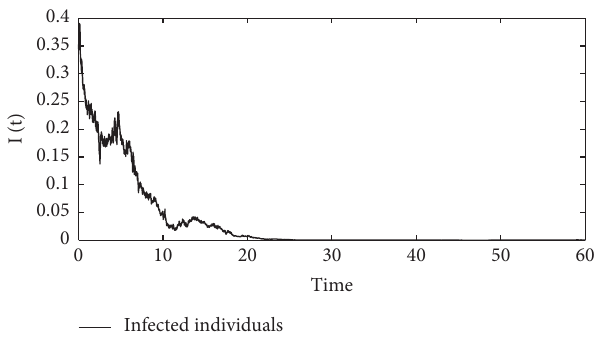
Figure 2: The stochastic trajectory of I ( t ) .